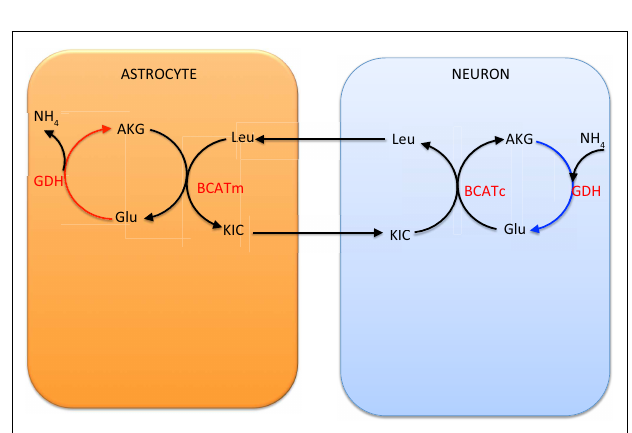
FIGURE 3 |The branched chain amino acid cycle . In order to effectively move the NH + from neuron to astrocyte, the latter has to be fixed to 4 α -ketoglutarate by mitochondrial GDH, thus requiring this reaction to go in the reductive direction, hence running into the same criticism as the lactate-alanine shuttle (see Figure 2 ).